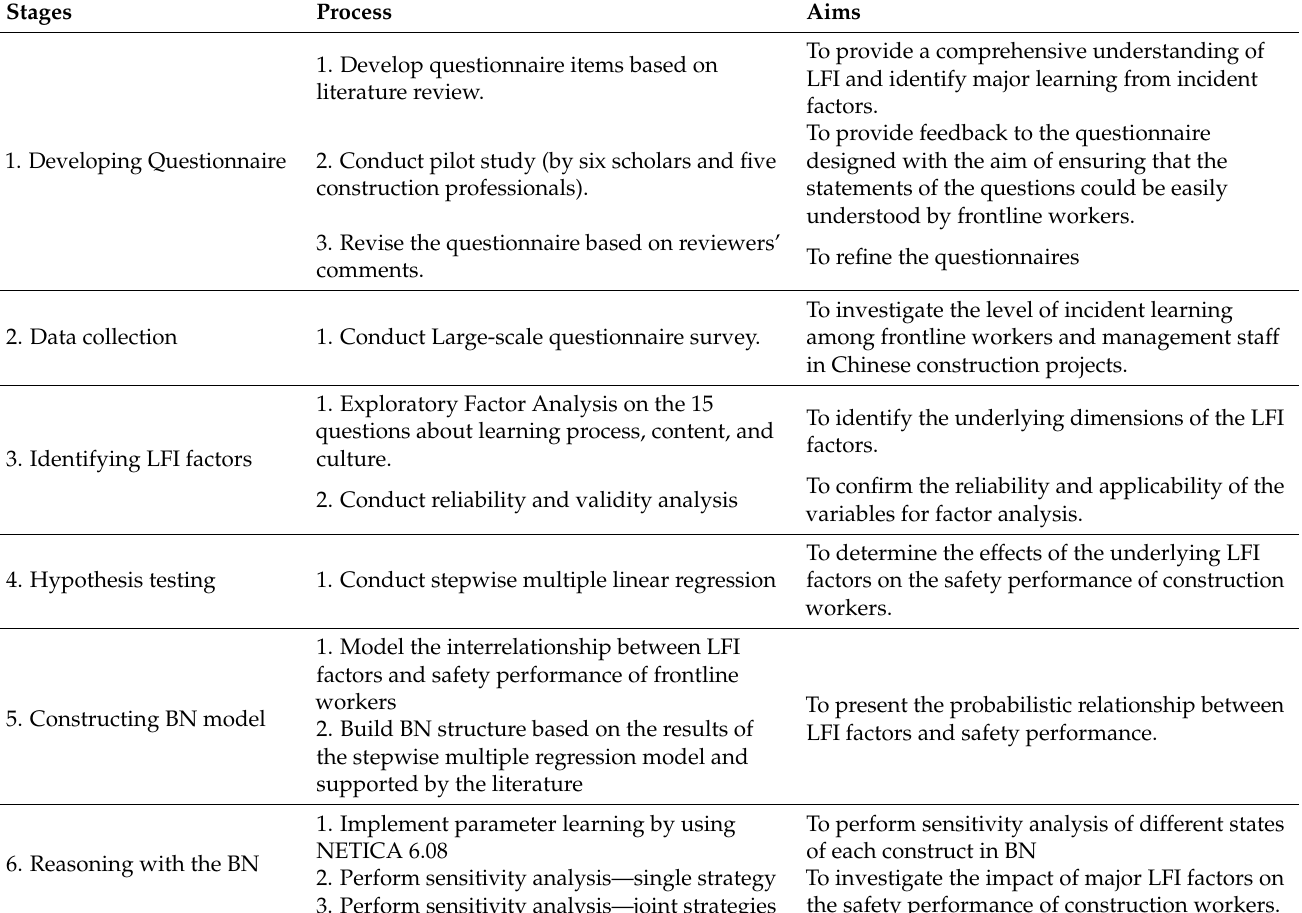
Table 3. The overall research